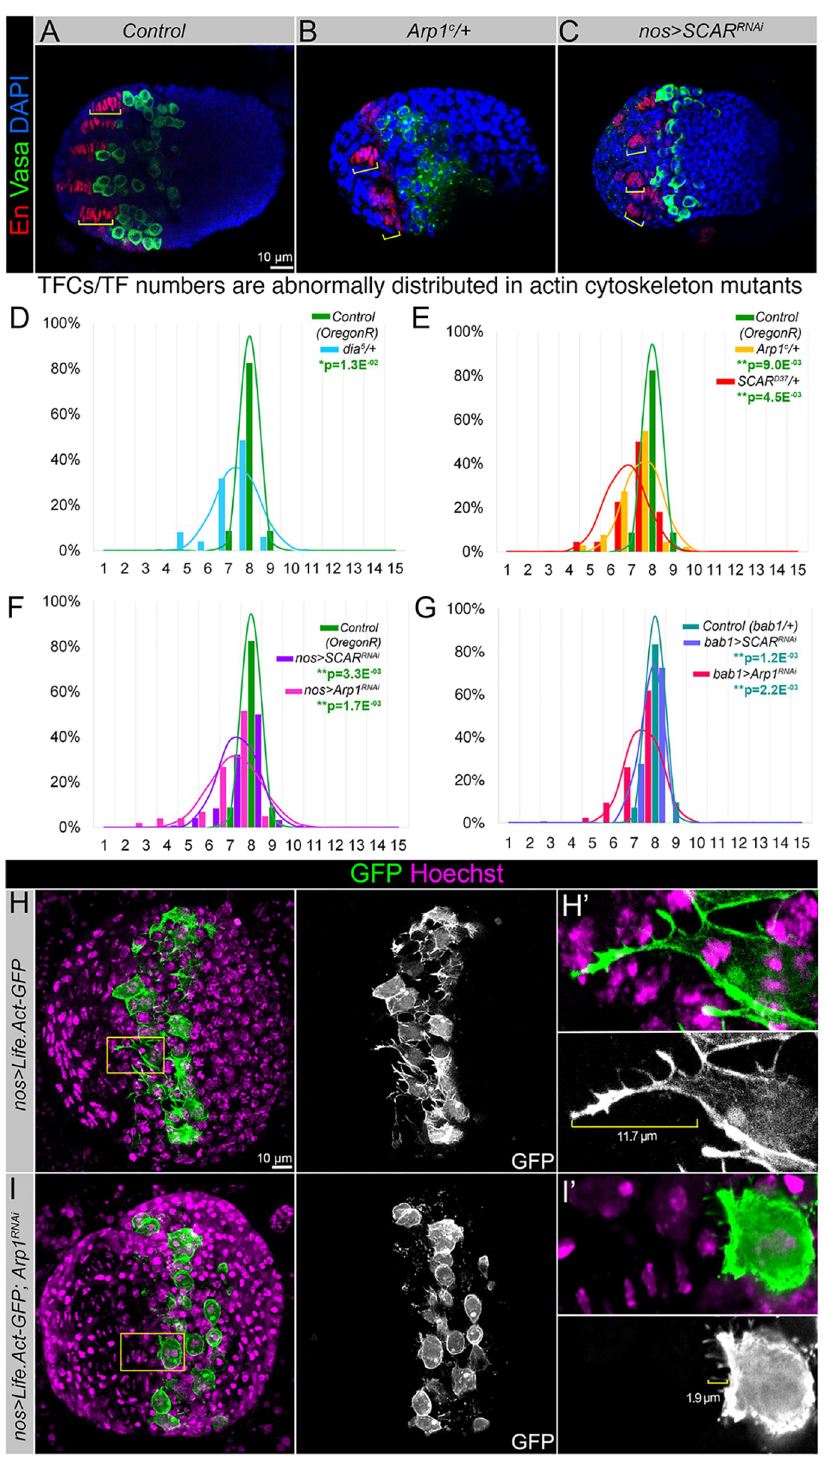
Fig 6. The length of TFs depends on actin dynamics. ( A-C ) Ovarian morphology is defective in actin cytoskeleton mutants. The brackets show the TF length in exemplary ovaries of the control ( Oregon R , A ), actin cytoskeleton heterozygous mutant ( Arp1 c /+ , B ), and mutants that have SCAR downregulated specifically in the germline ( nos > SCAR RNAi , C ). ( D-E ) Graphs represent the quantitative analysis of the variation of TFC numbers per TF. In actin cytoskeleton heterozygous mutants ( dia 5 /+ , Arp1 c /+ , SCAR d37 /+) , the distribution of the TFs containing different